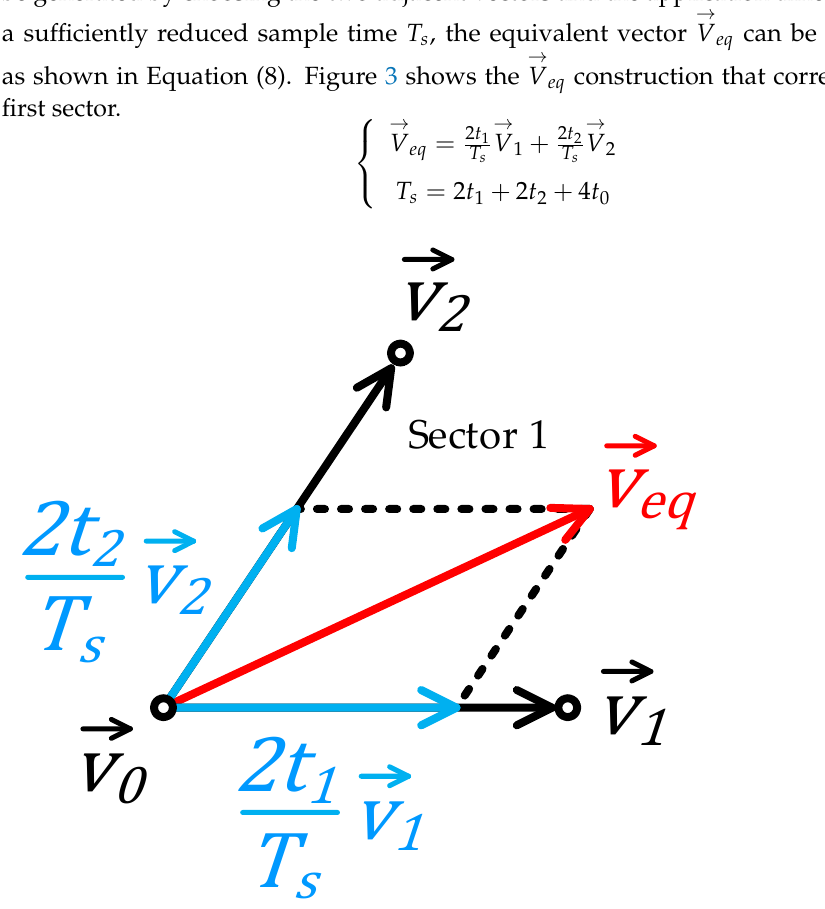
Figure 4. Seven-segment switching sequence for sector one.